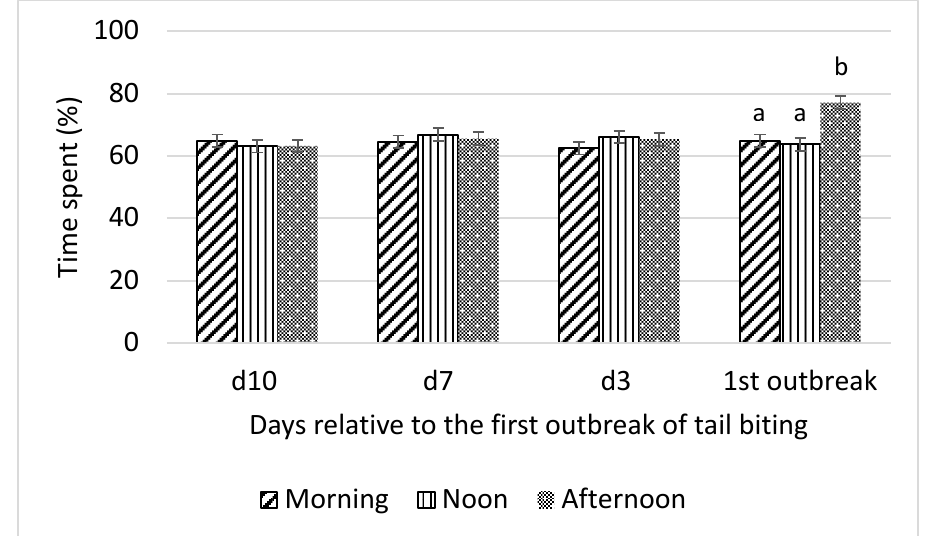
Figure 6. Interaction between day (10 d, 7 d, and 3 d before and during) relative to the first outbreak of tail biting and time of day (morning, noon, and afternoon) for time spent lying (% of observation time); ab — within days means without a common superscript differ ( p < 0.01).